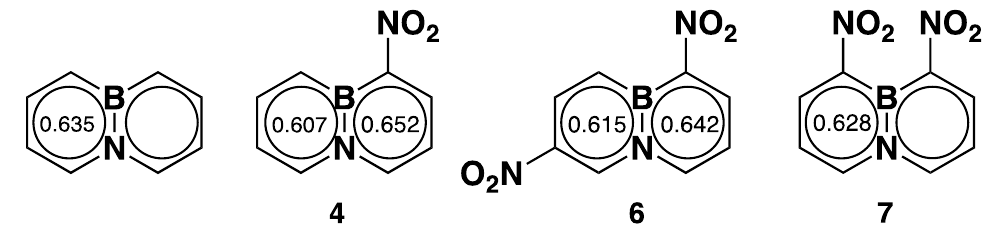
Figure 2. Aromaticity of nitro-BNNs calculated using HOMA